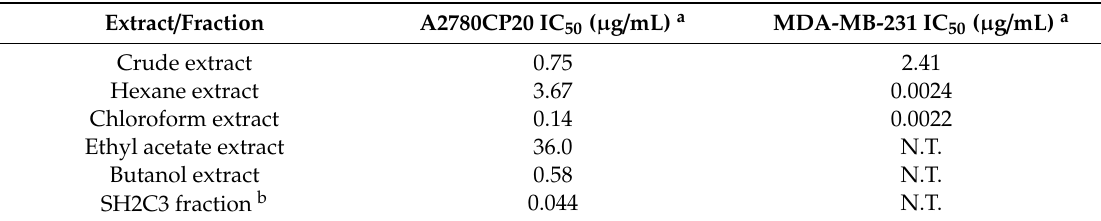
Table 2. Antiproliferative E ff ect of Simarouba Extract / Fraction on Ovarian (A2780CP20) and Breast (MDA-MB-231) Cancer Cell